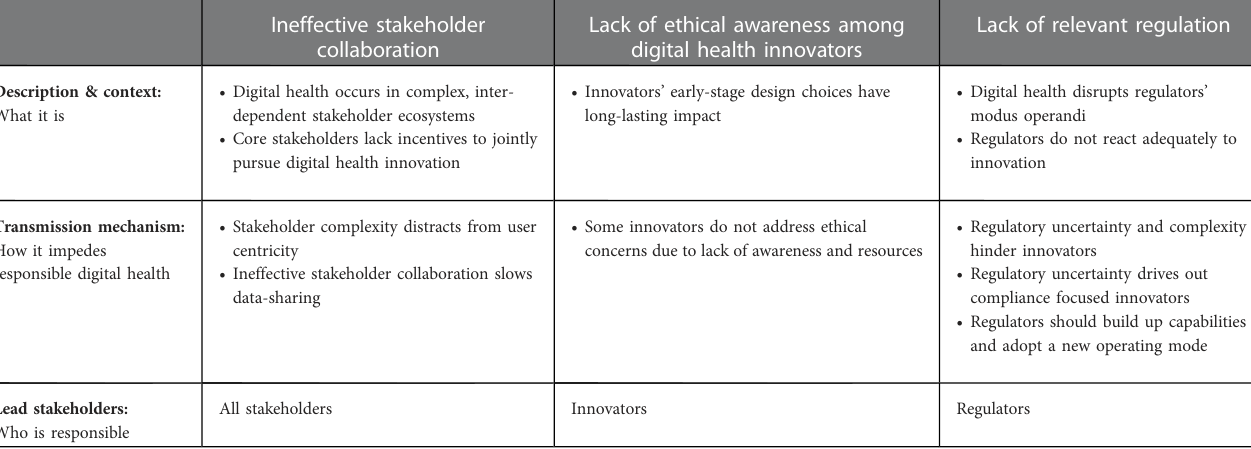
TABLE 3 Overview of the impediment